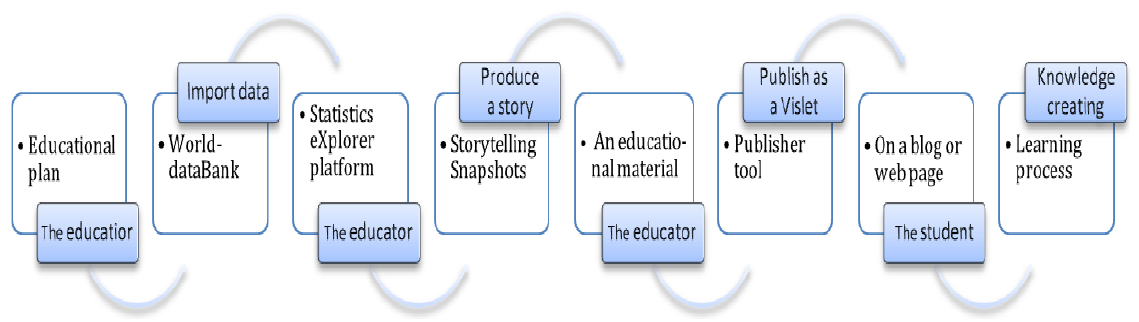
Figure 6. The process by which teachers converted an educational plan into interactive educational material, a Vislet, on the web, where students interacted with the